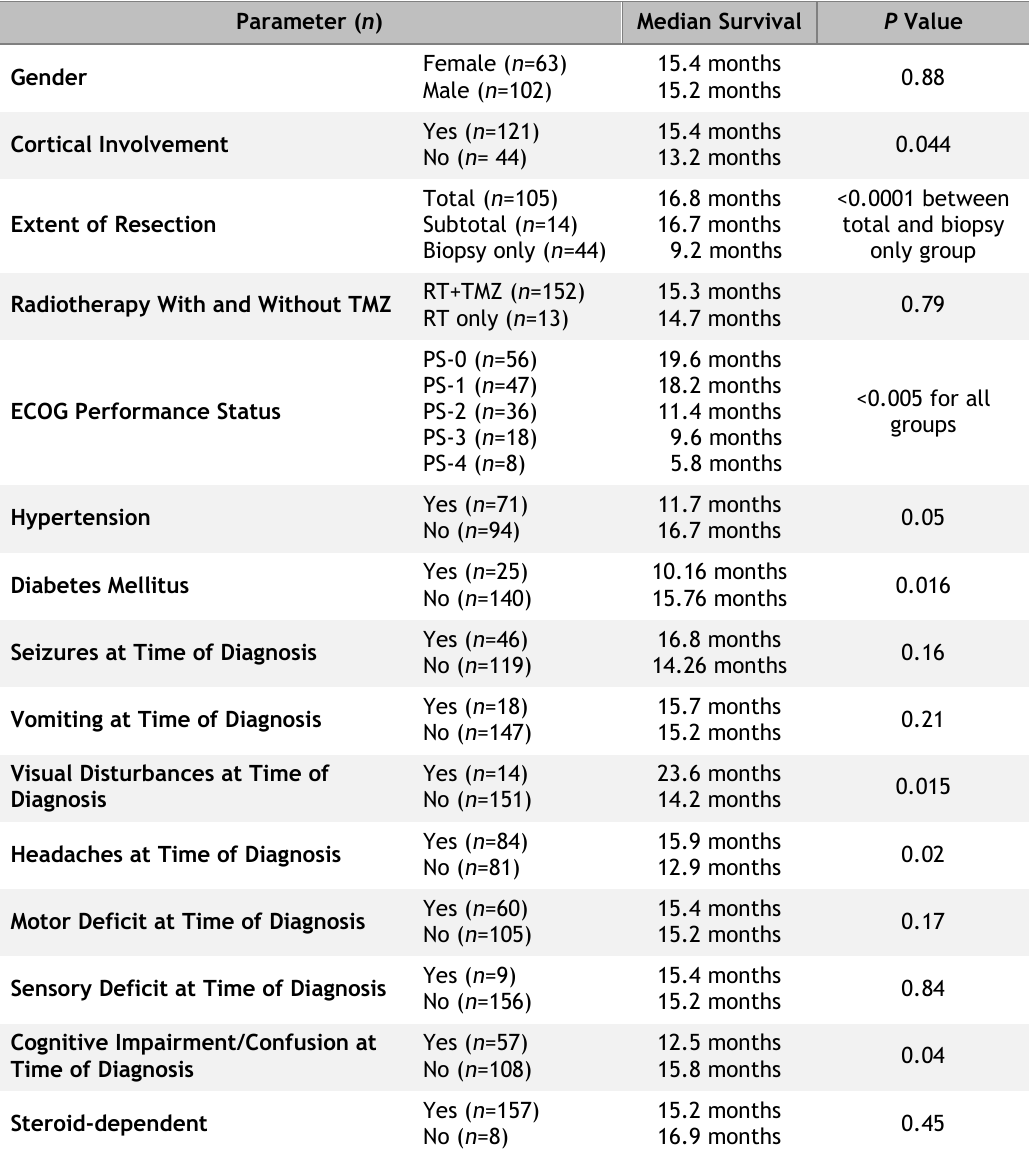
Table 1. Univariate Analysis of Clinical Factors to Predict